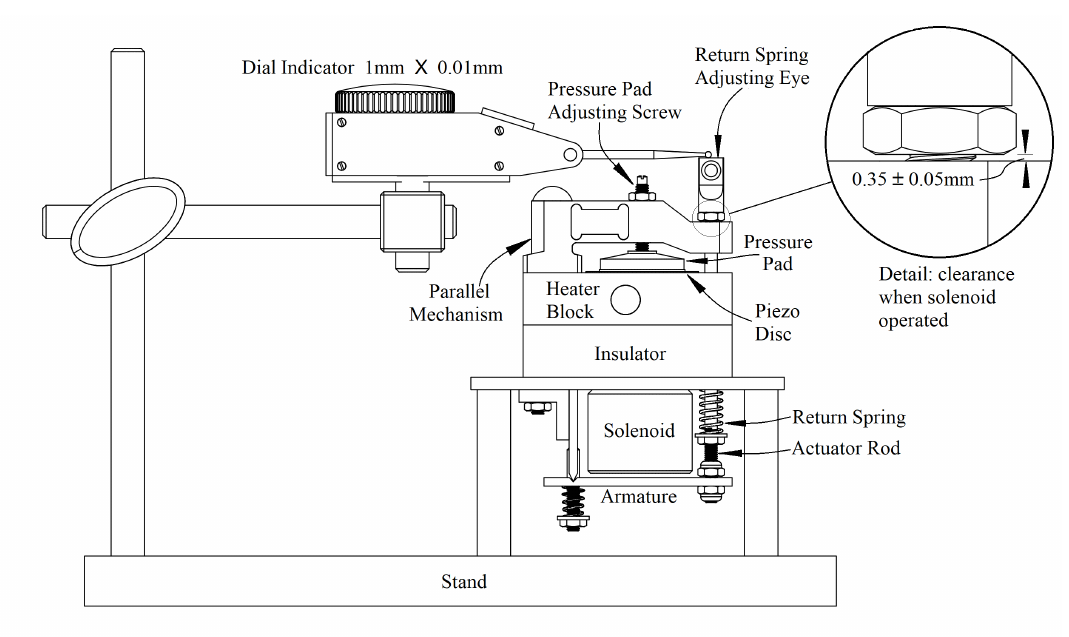
Figure 3. Test equipment for obtaining temperature response and ageing